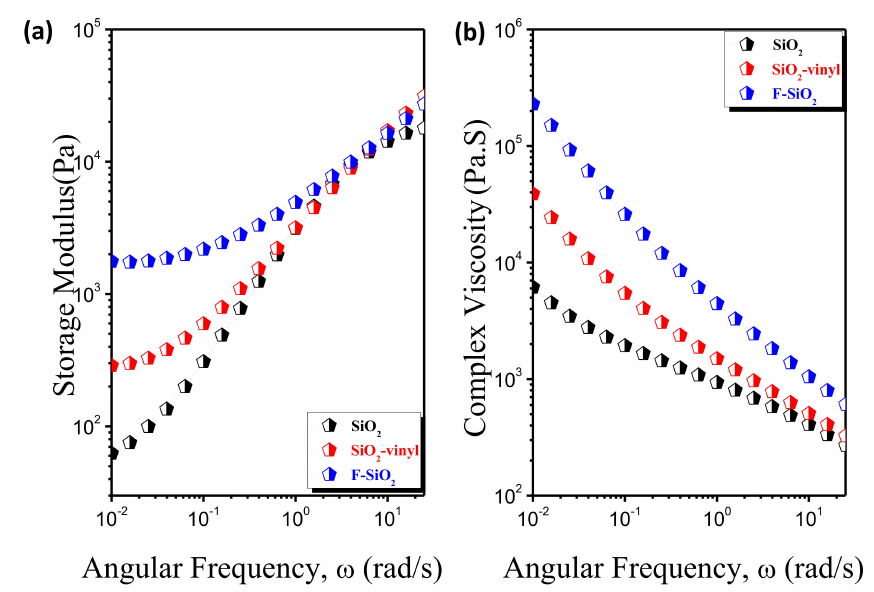
Figure 11. The storage modulus ( a ) and complex viscosity ( b ) of the PVDF matrix incorporated with 3 wt% pristine SiO 2 , SiO 2 -vinyl, and F-SiO 2 nanoparticles, respectively.